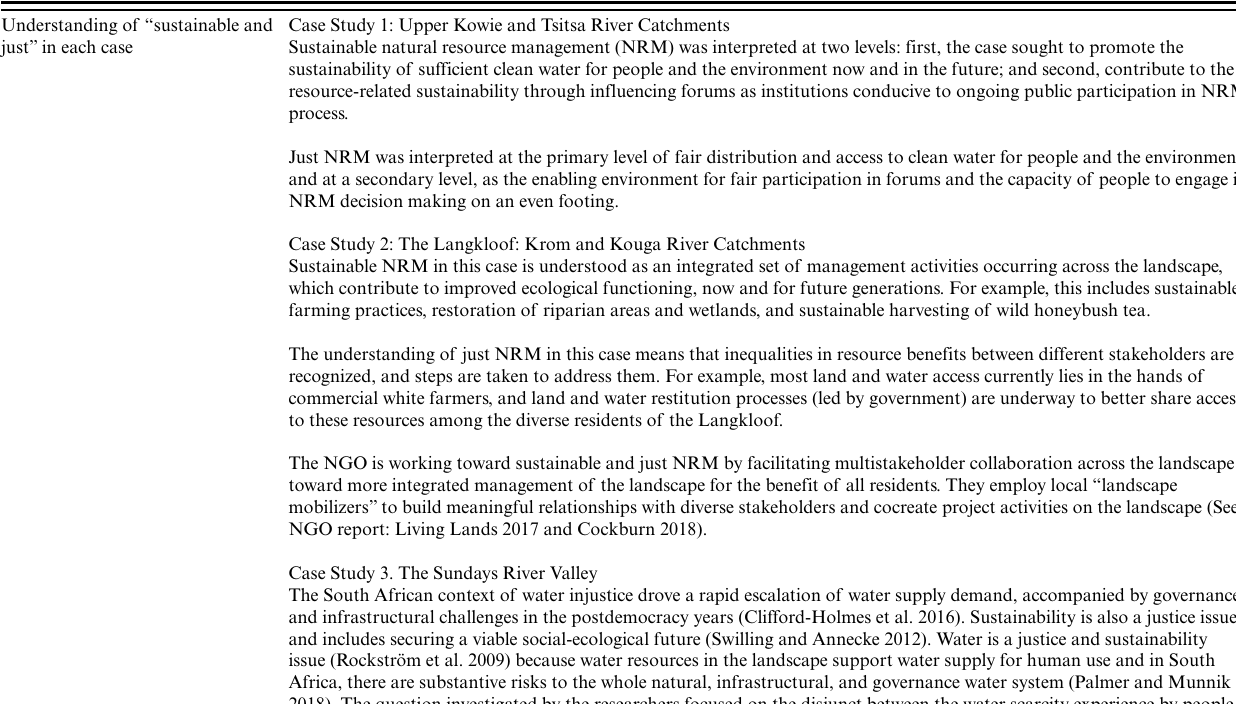
Table 3 . Interpretation of “sustainable and just” evidence of ethics and